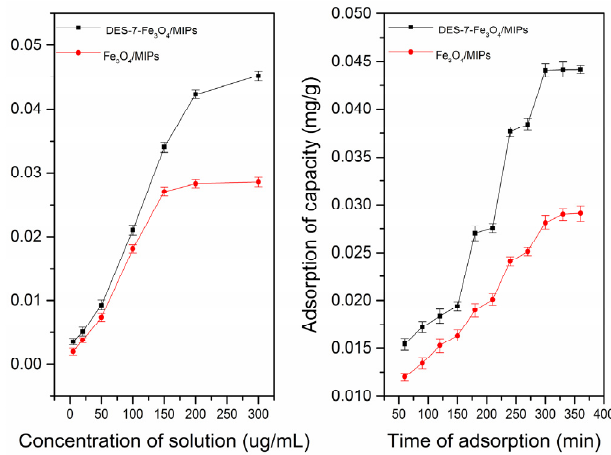
Figure 4. The static and dynamic adsorption capacity curves of two materials (Fe 3 O 4 /MIPs, and DES-7-Fe 3 O 4 /MIPs) for Theobromine.